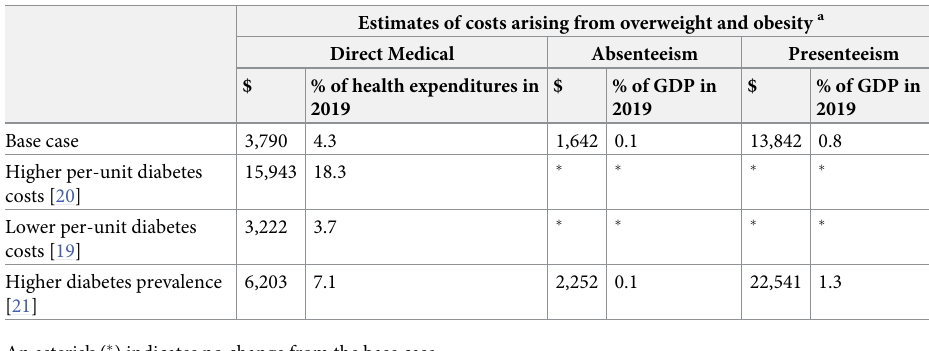
Table 2. Sensitivity